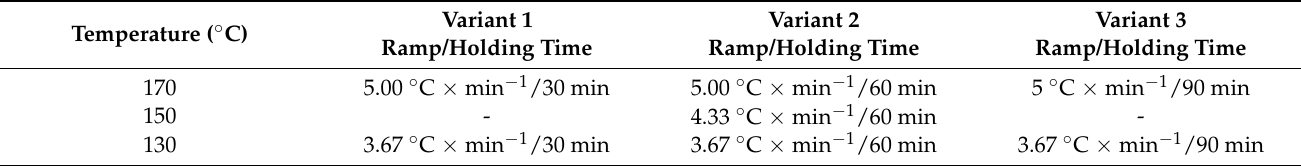
Table 1. Experimental setup with different treatment temperatures and different holding time variants for the hydrothermal treatment of forest residues and